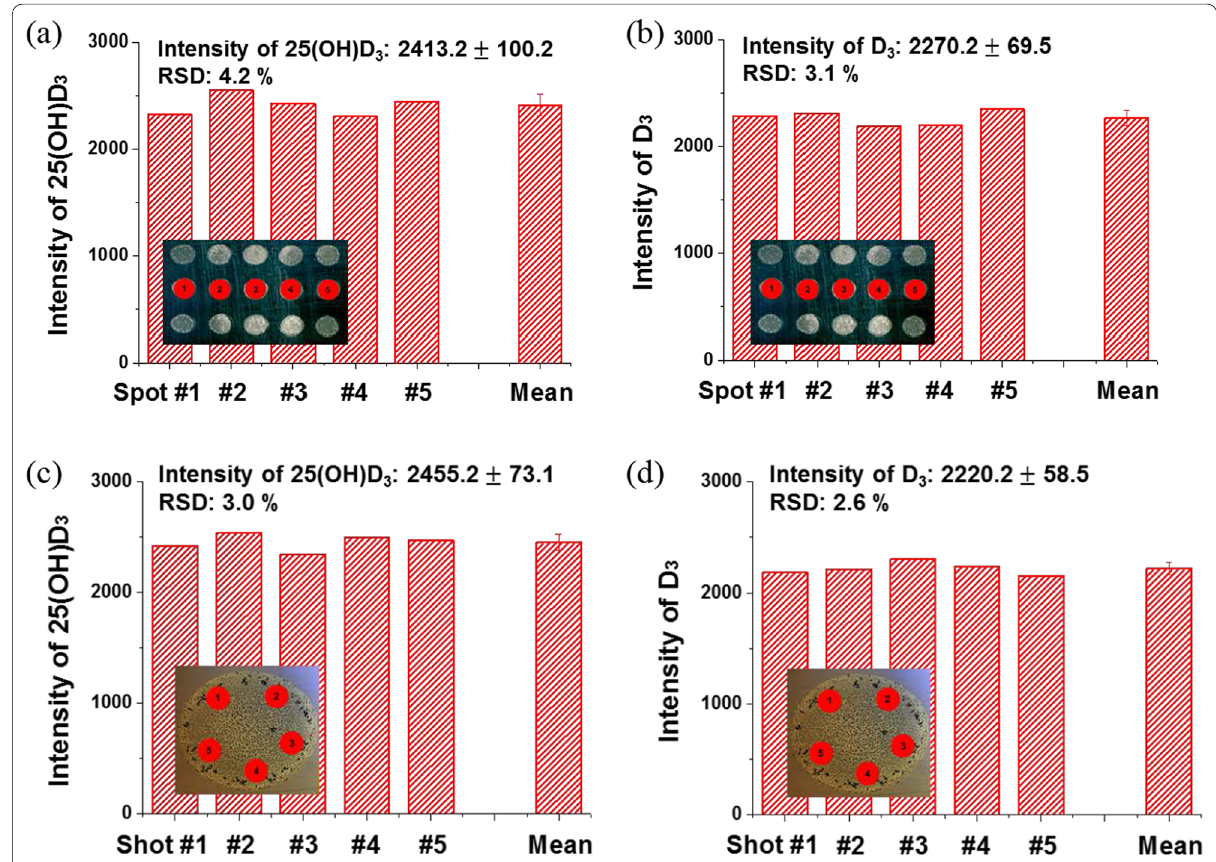
Fig. 4 Reproducibility of the parylene matrix chip. a Spot‑to‑spot reproducibility of 25(OH)D 3 . b Spot‑to‑spot reproducibility of D 3 . c Shot‑to‑shot reproducibility of